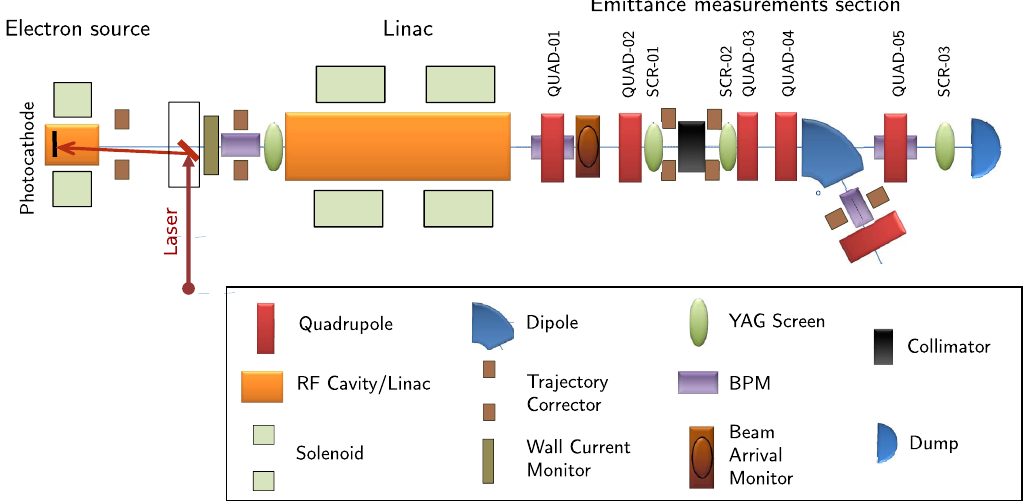
FIG. 1. Layout of CLARA FE (not to scale), showing the electron source, magnetic elements, linac, and diagnostics. For the emittance measurements, quadrupoles QUAD-01 and QUAD-02 were used to set the required optics at screen SCR-01. For each measurement, beam images on SCR-03 (the observation point) were recorded for different strengths of quadupoles QUAD-03, QUAD-04 and QUAD- 05. The optical functions and phase space distribution were computed at SCR-02 (the reconstruction point). Screens SCR-01, SCR-02 and SCR-03 are 0.61 m, 1.53 m and 3.20 m from the entrance of QUAD-01, respectively.